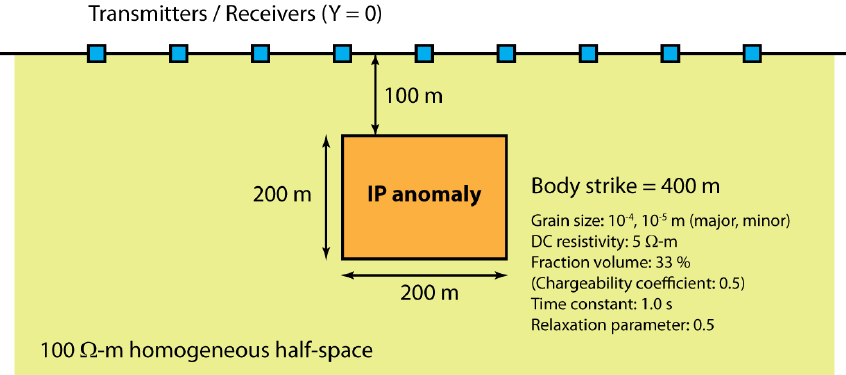
Figure 1. A 3D IP model used for the model